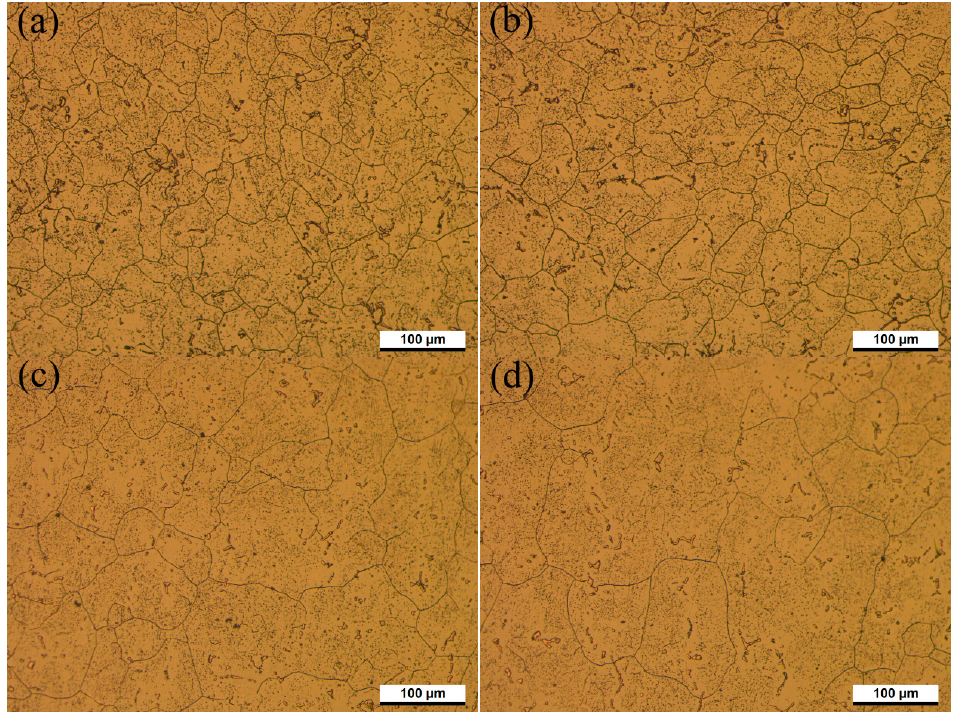
Figure 8. Effect of solution temperature and solution time on microstructure evolution at ( a ) 1170 °C for 0.5 h; ( b ) 1170 °C for 2 h; ( c ) 1200 °C for 2 h; and ( d ) 1230 °C for 3 h.